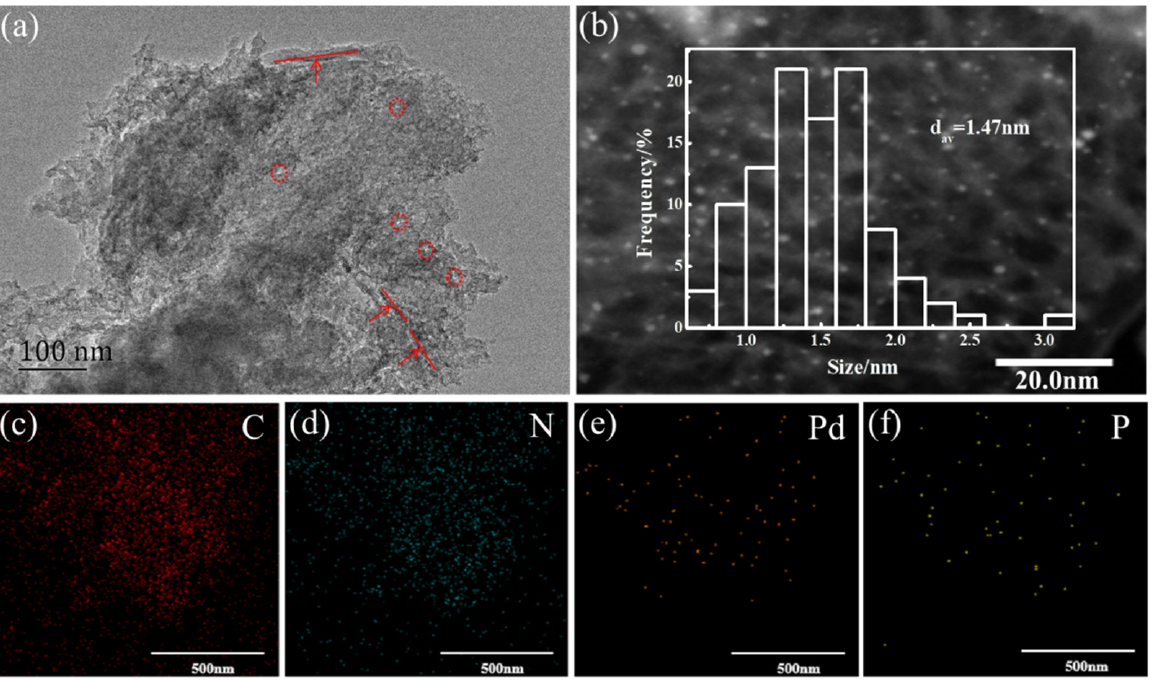
Figure 1. ( a ) TEM image of NH 2 - P - GC, ( b ) HRTEM image and histograms with Pd nanoparticle size distributions of Pd/NH 2 - P - GC, ( c – f ) EDS elemental mappings of Pd/NH 2 - P - GC.